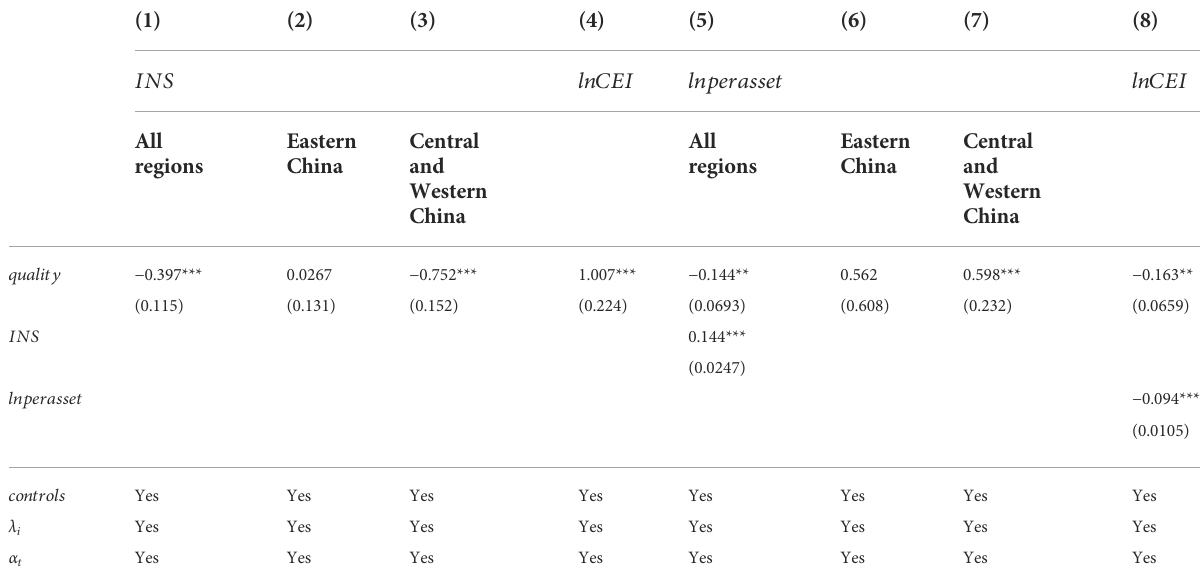
TABLE 8 Composition effect.